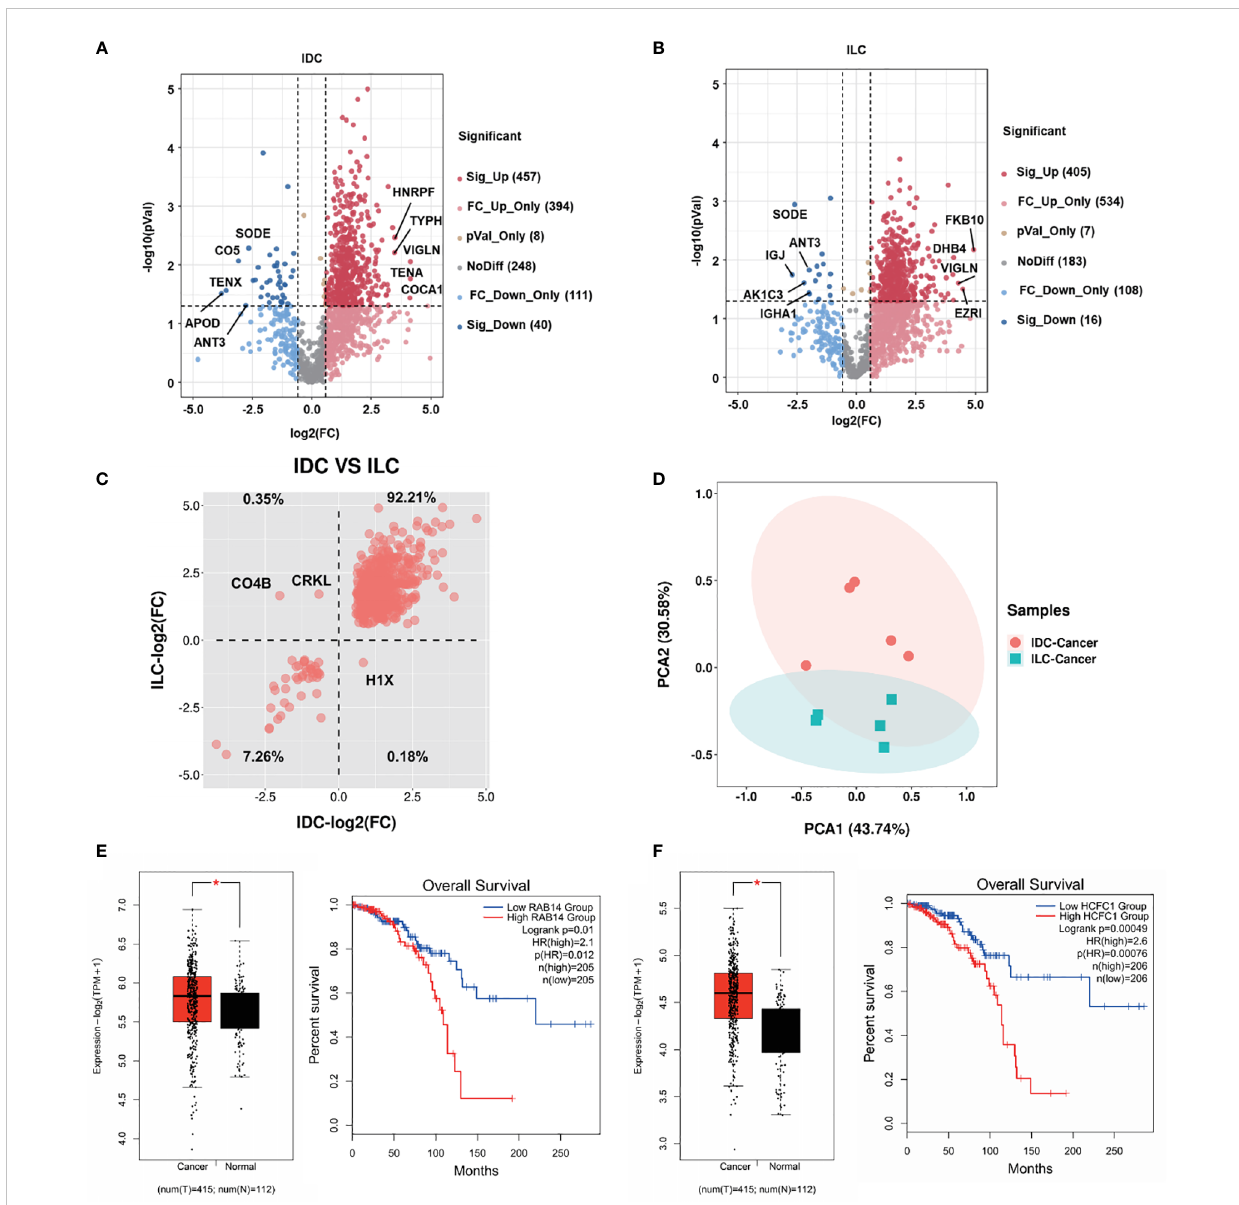
FIGURE 2 Proteome relative abundance difference and clinical signi fi cance of IDC and ILC from luminal A breast cancer. (A) , (B) Differential proteins between tumors and NATs from the IDC and ILC subtypes. Red: upregulated proteins blue: downregulated proteins (P-value < 0.05 from t-test and fold change > 1.50). (C) Intertumor comparative analysis of differential proteins from IDC and ILC. The second quadrant shows that the proteins are downregulated in IDC and upregulated in ILC, and the fourth quadrant shows the opposite. (D) PCA of selected proteins in 10 paired cancer tissues. Red: IDC cancer, and green: ILC cancer. (E-F) The mRNA expression and Kaplan-Meier survival analysis of signi fi cantly differential proteins (Ras- related protein Rab-14: RAB14; Host cell factor 1: HCFC1) in the Luminal A breast cancer using TCGA database. *,